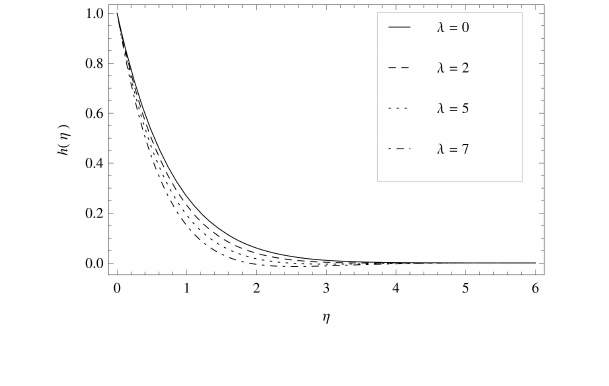
Fig. 22: Comparison of Wang [9] and HAM solution for velocity func- tion f (cid:48) ( η )